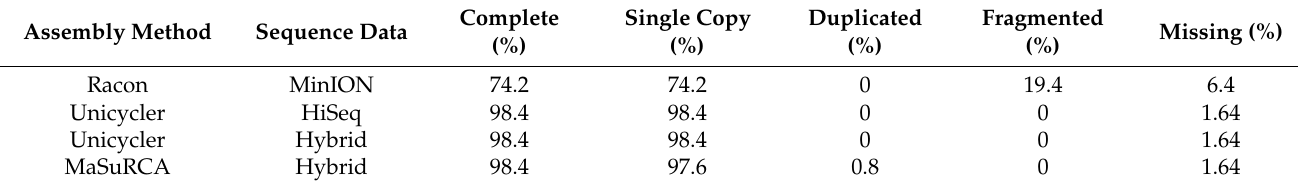
Table 4. Salmonella SE3 genome features annotated by Prokka.